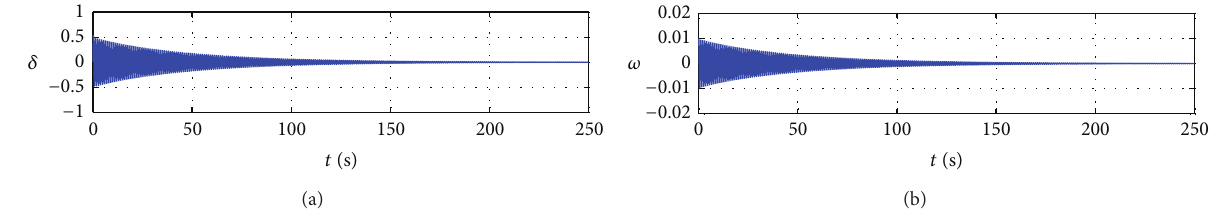
Figure 7: Time waveforms of 𝛿 and 𝜔 with 𝐾 𝑖 = 1 , 𝐾 𝑝 = 2 , and 𝐾 𝑑 = 0.8 .